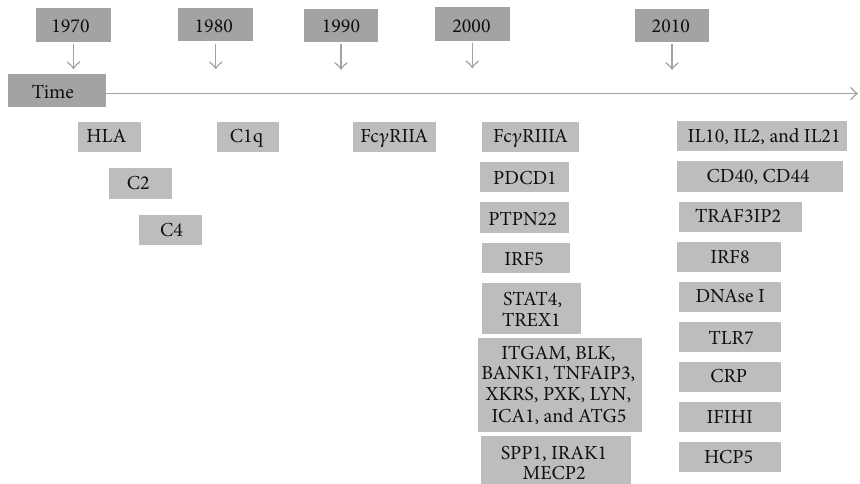
Figure 1: Schematic representation of genetic variants associated with SLE susceptibility identified from